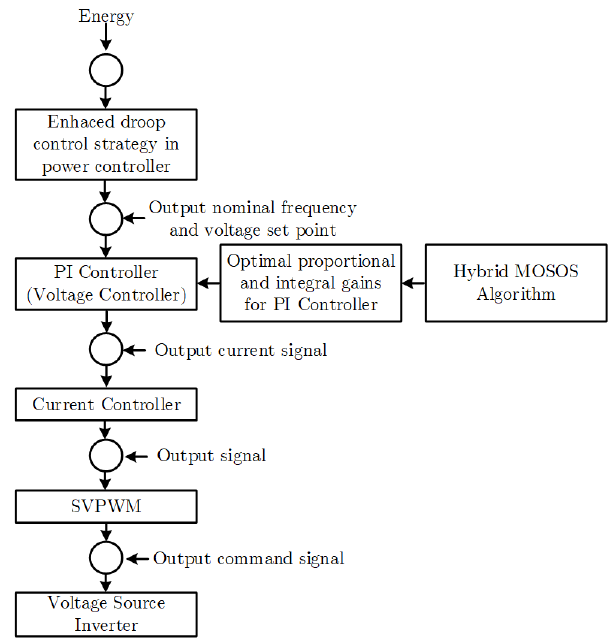
Figure 7. Flow diagram of multi-objective symbiotic organism search (MOSOS) multi-objective control